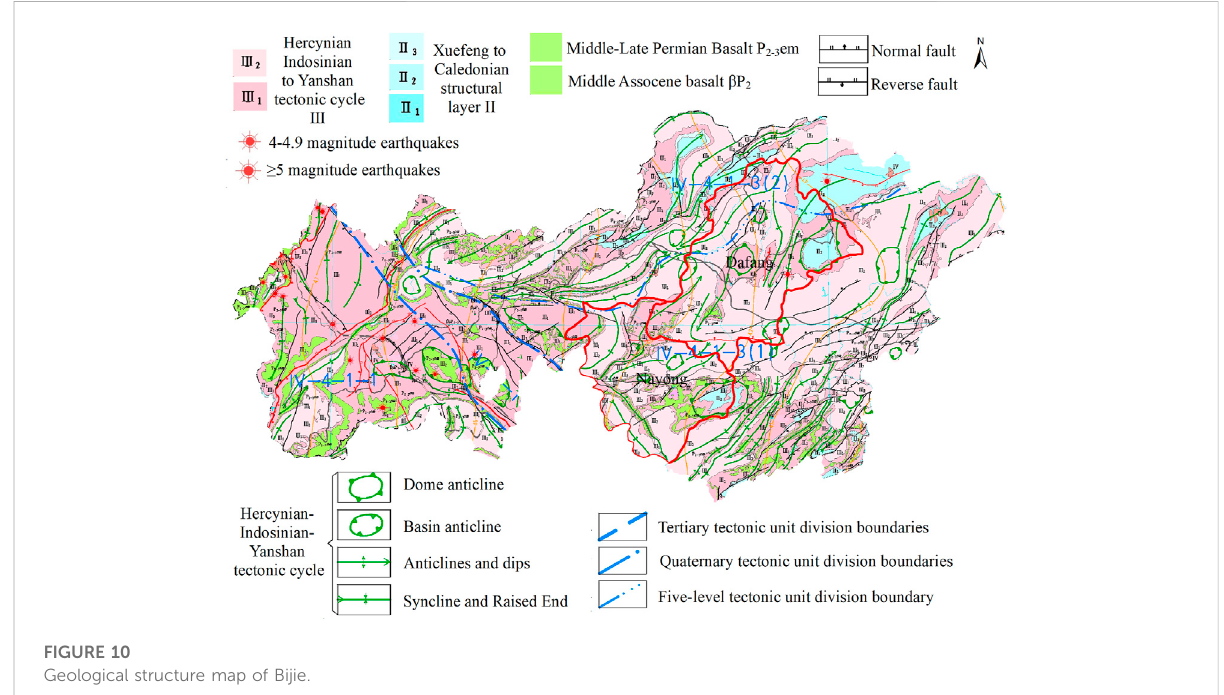
FIGURE 10 Geological structure map of Bijie.